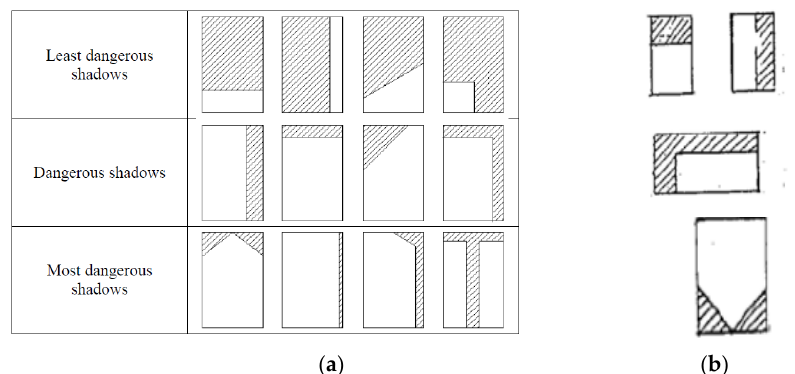
Figure 9. Examples of shadows on glass from: ( a ) CNR DT 210 [121] and ( b ) Belgian Guidelines [148].